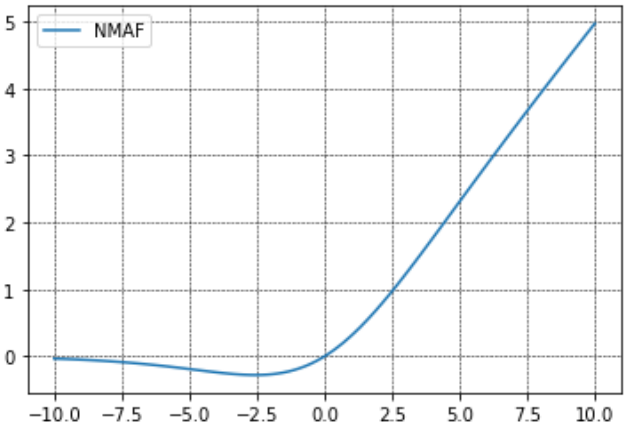
Figure A4. Graph of the proposed non-monotonic activation function (NMAF).